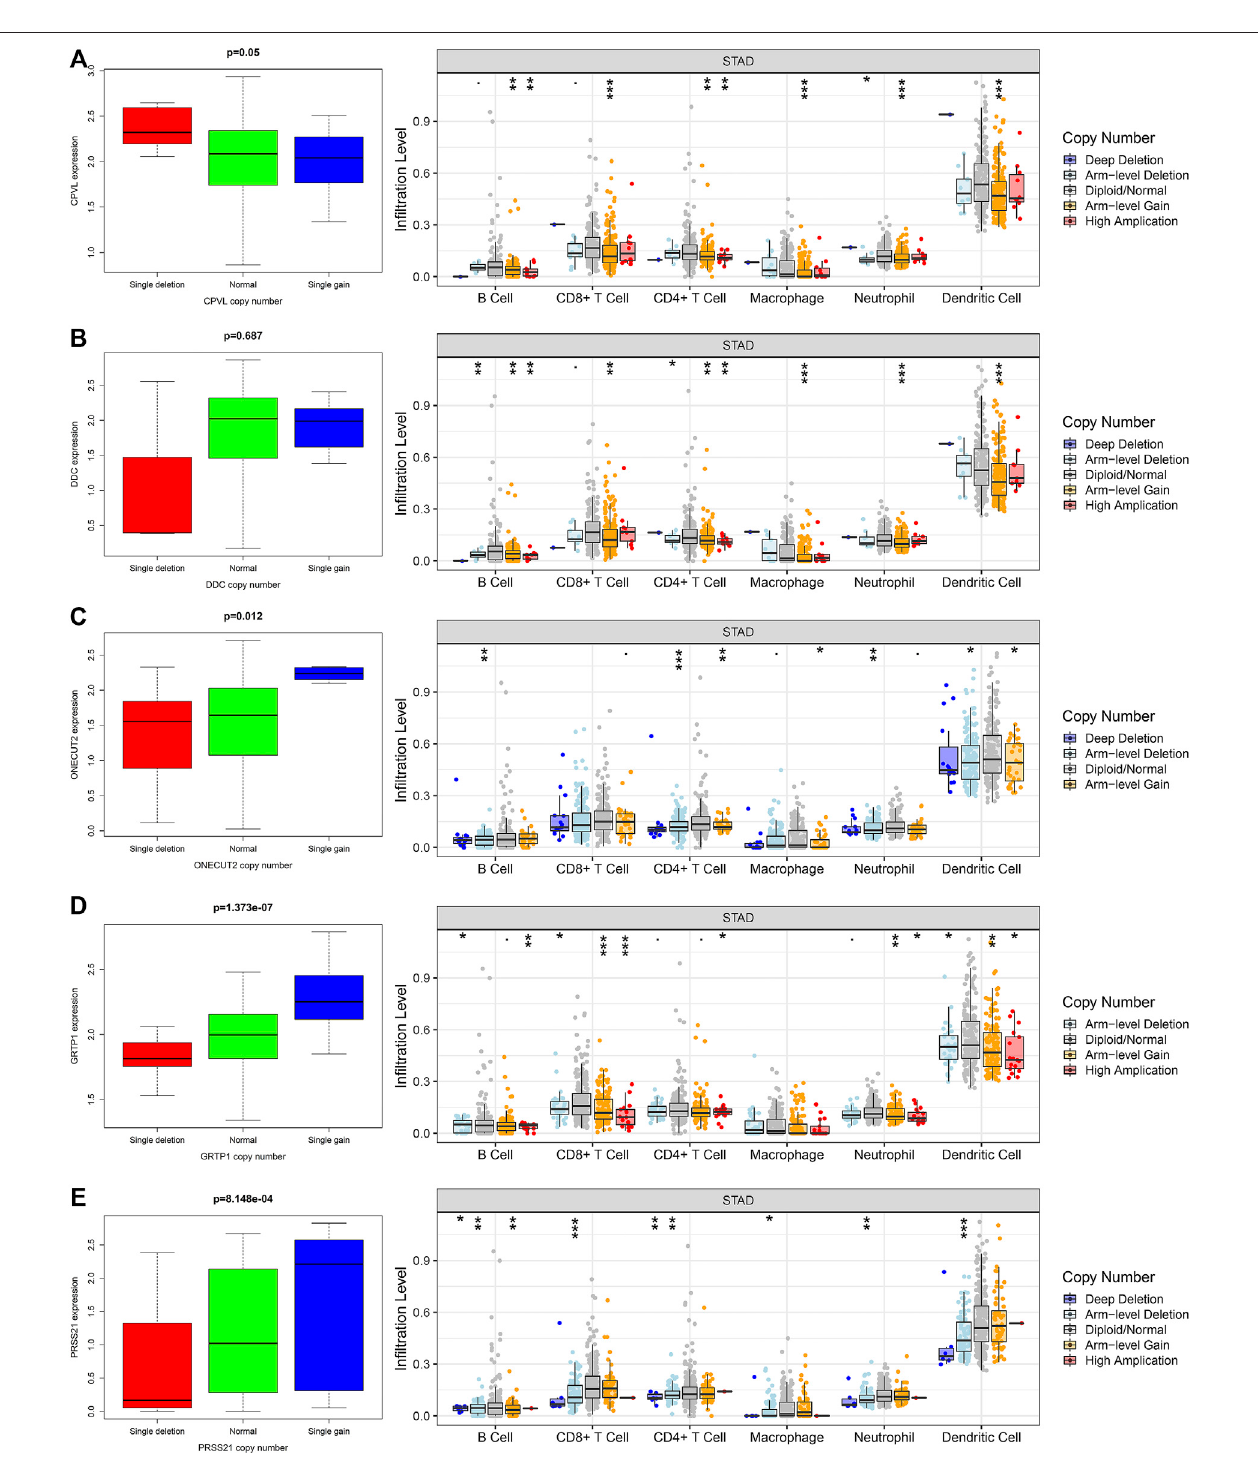
FIGURE6| Therelationshipbetweenthehubgenes,CNVsandlevelofimmunein fi ltrationingastriccancer.TheexpressionandCNVsof (A) CPVL, (B) ONECUT2, (C) DDC, (D) PRSS21 and (E) GRTP1 showed association with the immune cell in fi ltration in gastric cancer. * p < 0.05, ** p < 0.01, *** p < 0.001.